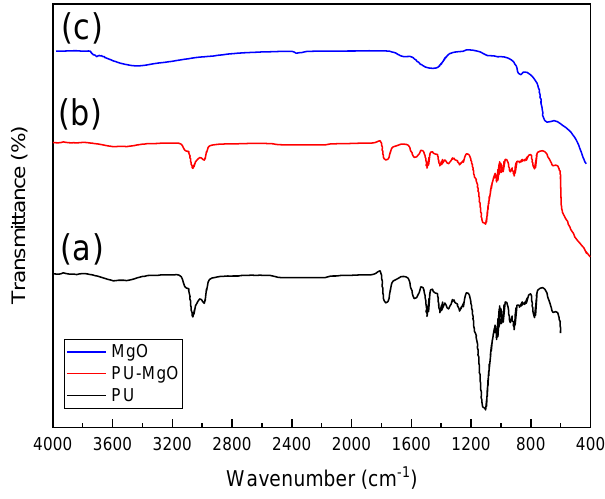
Figure 3. FTIR spectra of ( a ) PU, ( b ) PU-MgO, and ( c ) MgO nanohybrids. Figure 4 presents the TGA curves of the PU, MgO, and PU-MgO nanohybrids. In the thermogram related to nano-MgO, a total weight loss of about 5% was observed at temperatures lower than 200 °C. This weight loss was related to moisture and carbon dioxide absorbed from the environment and has also been reported in other studies on MgO [53,54]. As can be seen, pure polyurethane is completely burned above 410 °C. From the